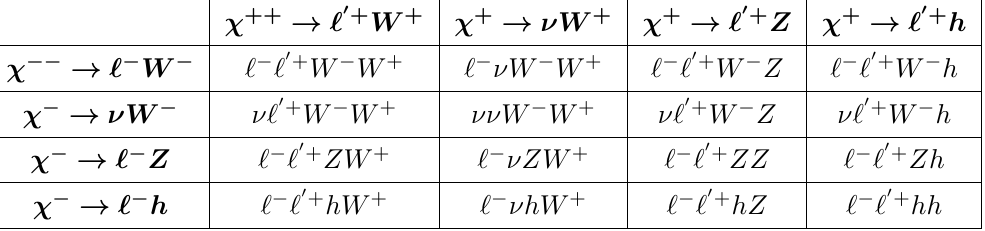
Table 4 . Possible final state signatures of pair/associated productions of charged exotic